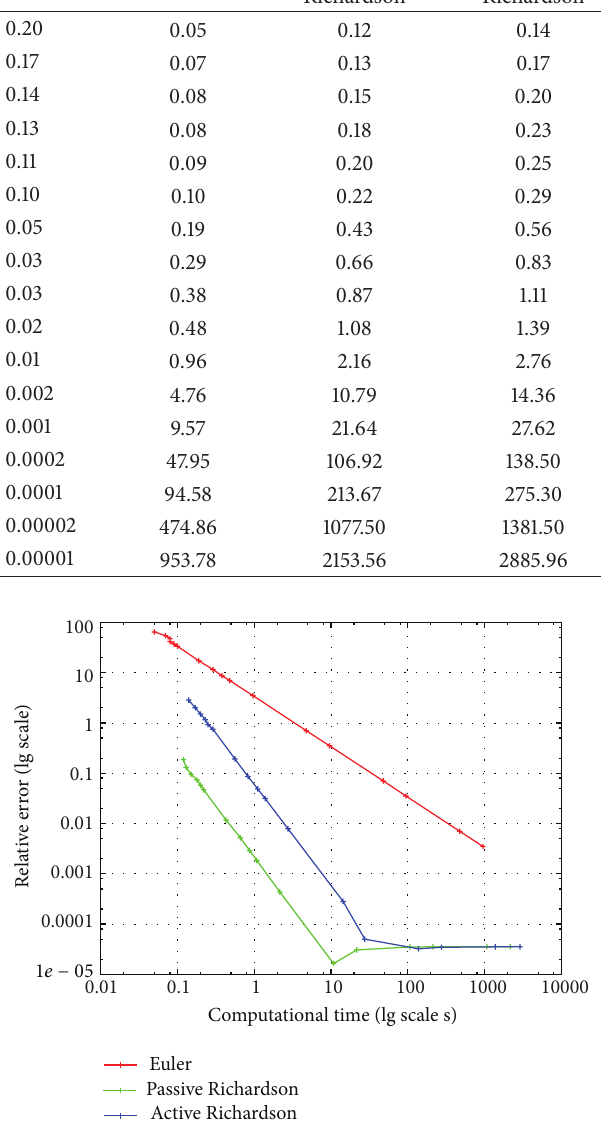
Figure 4: Relative error as a function of computational time for the Euler method without and with passive and active Richardson extrapolation, by grid step Δ𝑥 = 1 and coefficient 𝐷 = 1.0 . The reference solution was calculated using Δ𝑡 = 10 −7 .